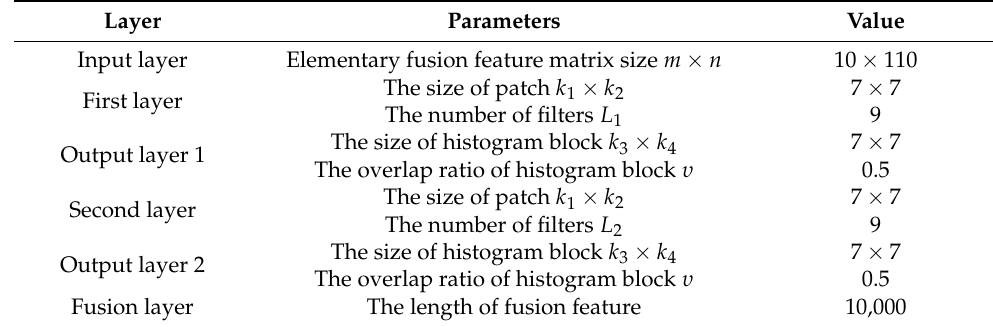
Table 1. PCANet fusion structure and parameter